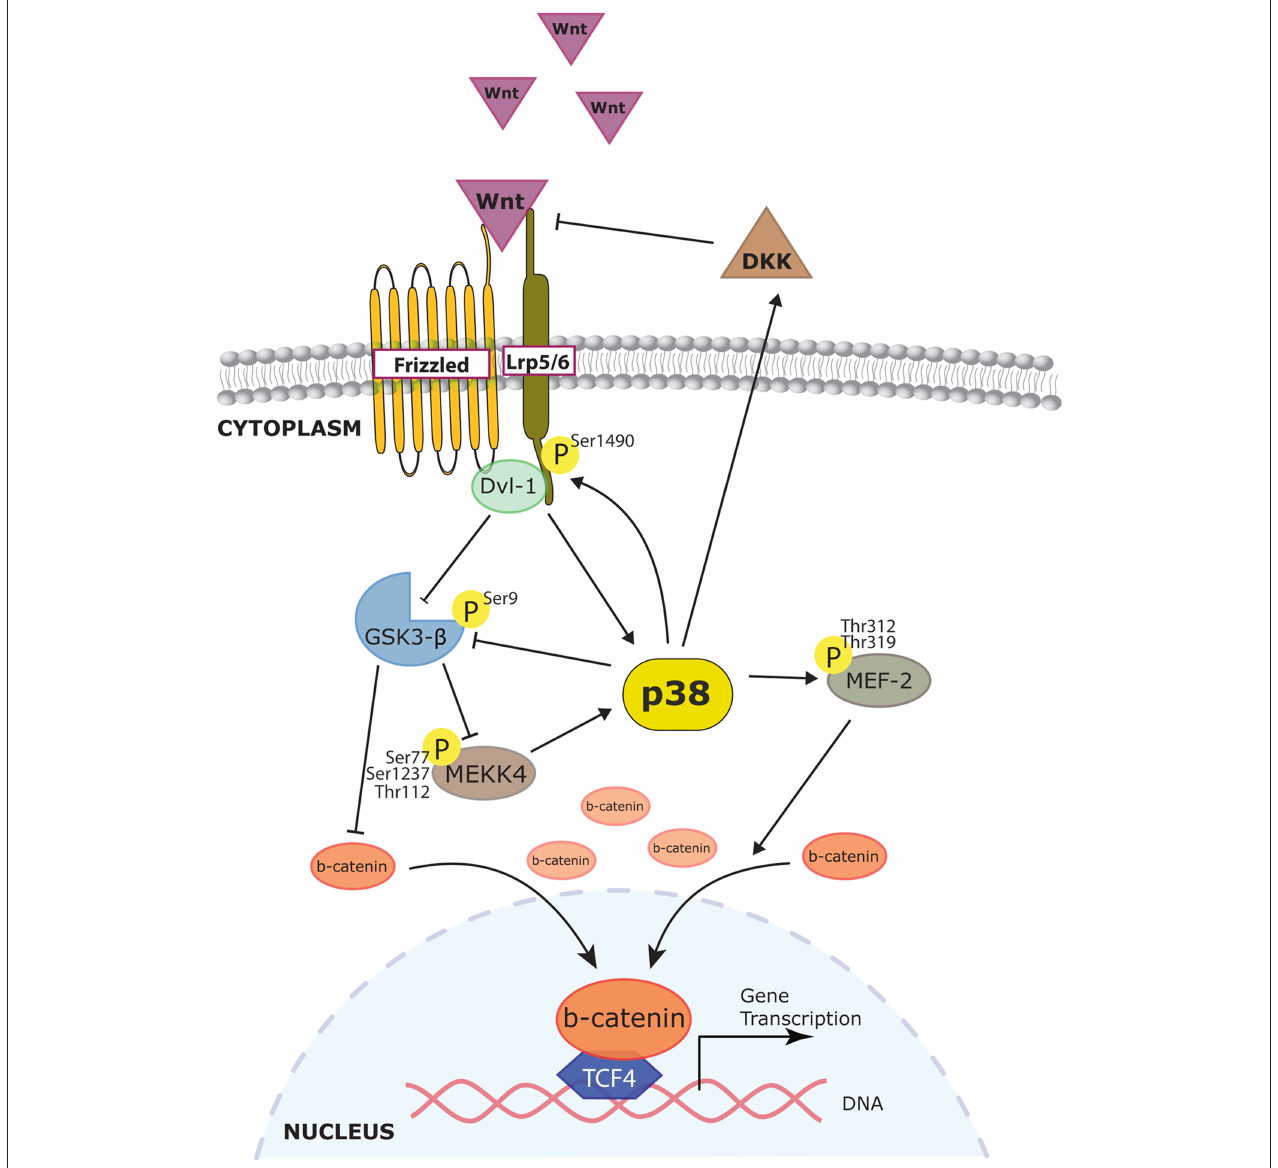
FIGURE 4 | Role of p38 MAPK in Wnt signaling. Wnt pathway activation leads to β -catenin accumulation, which enables β -catenin to translocate and initiate the transcription of target genes. p38 participates in the regulation of β -catenin accumulation by targeting different steps of the Wnt signaling. Wnt can activate p38 through Disheveled (Dvl) proteins and at the same time also inactivate GSK3 β allowing β -catenin to accumulate. Activated p38 can reinforce GSK3 β inhibition therefore increasing cytoplasmic β -catenin. Moreover, effects of p38 phosphorylation on MEF2 also enhance β -catenin nuclear accumulation. p38 also exerts negative effects on Wnt signaling since DKK-1 expression (a Wnt inhibitor) relies on p38